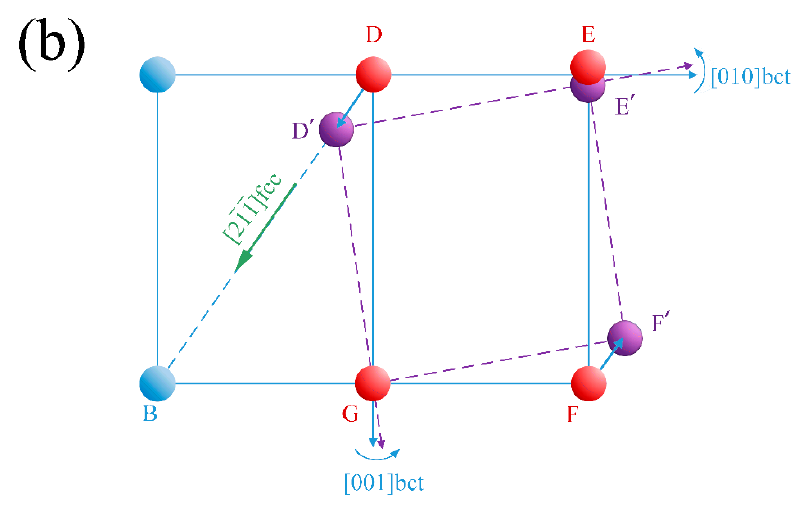
Figure 11. The lattice change during the bainitic transformation (fcc to bcc); ( a ) lattice rotation in V1 relationship, (111) γ //(111) α , [211] γ //[011] α ; ( b ) lattice distortion as Shockley partial dislocation mechanism on the (011) fcc plane.